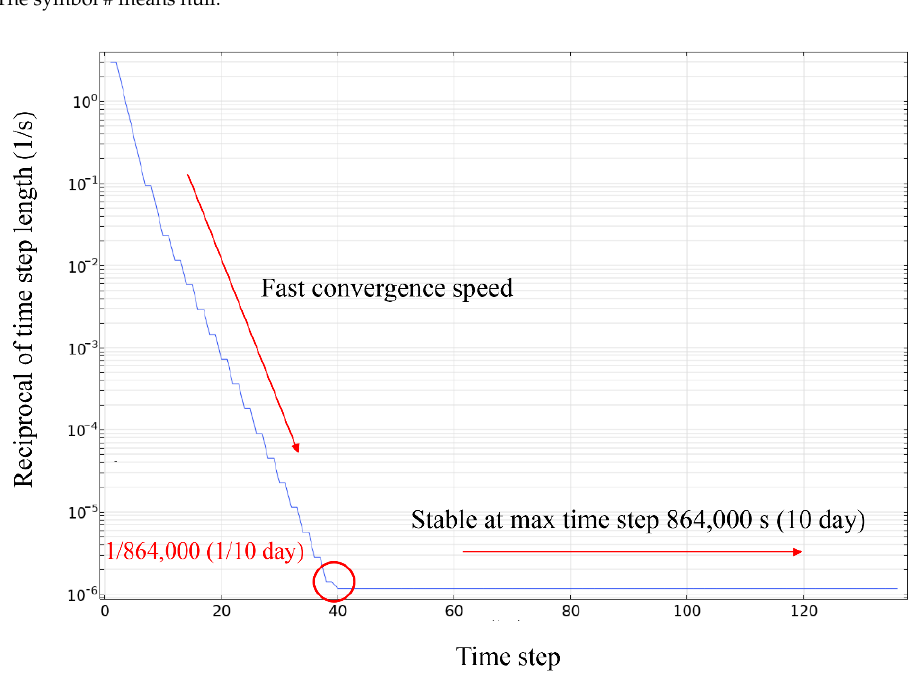
Figure 5. Convergence plot of the numerical model.